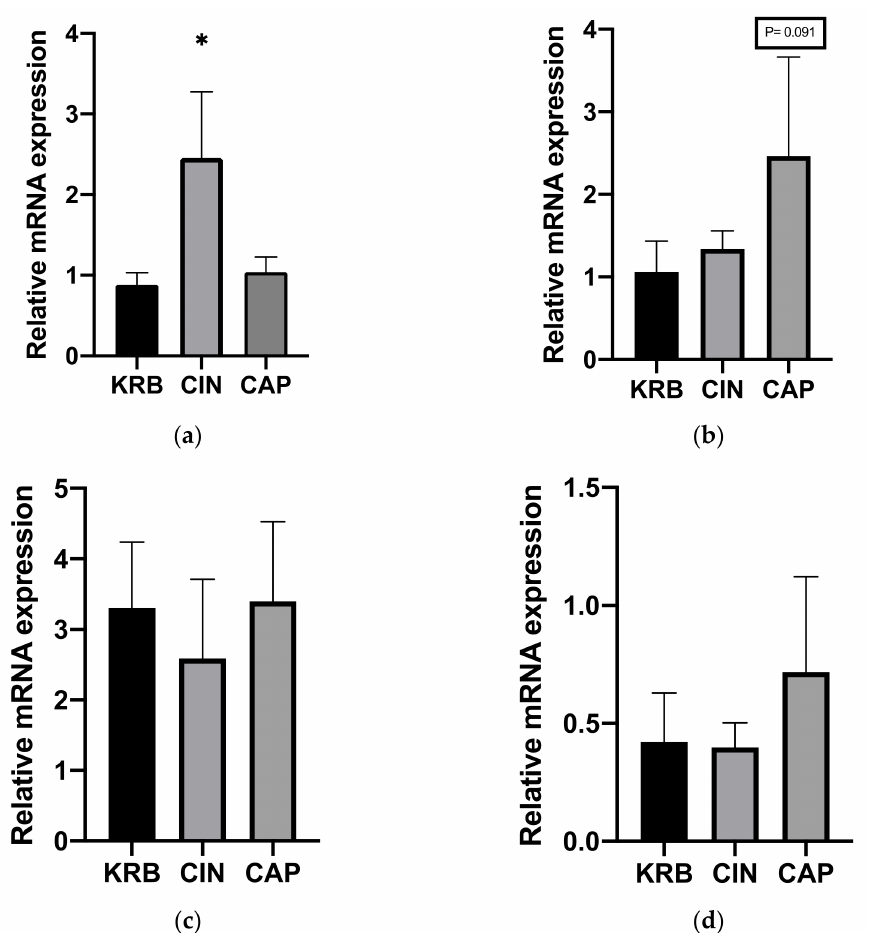
Figure 2. Effect of control KRB buffer (KRB), cinnamaldehyde (200 µ mol L − 1 , CIN) and capsaicin (20 µ mol L − 1 , CAP) on TRPA1 ( a ), TRPV1 ( b ), CCK ( c ) and GLP-1 ( d ) gene expression levels. Signifi- cant differences compared to KRB are indicated with asterisks: * p < 0.05, number of replicates was n = 6, error bars express the